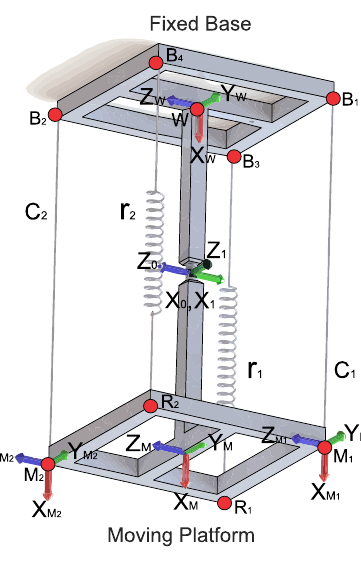
Figure 2. Reference